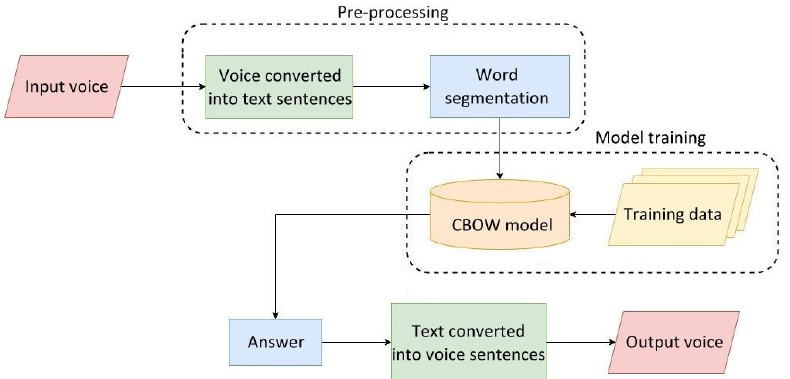
Figure 15. Flowchart of the Chinese speech recognition system used in care robots.